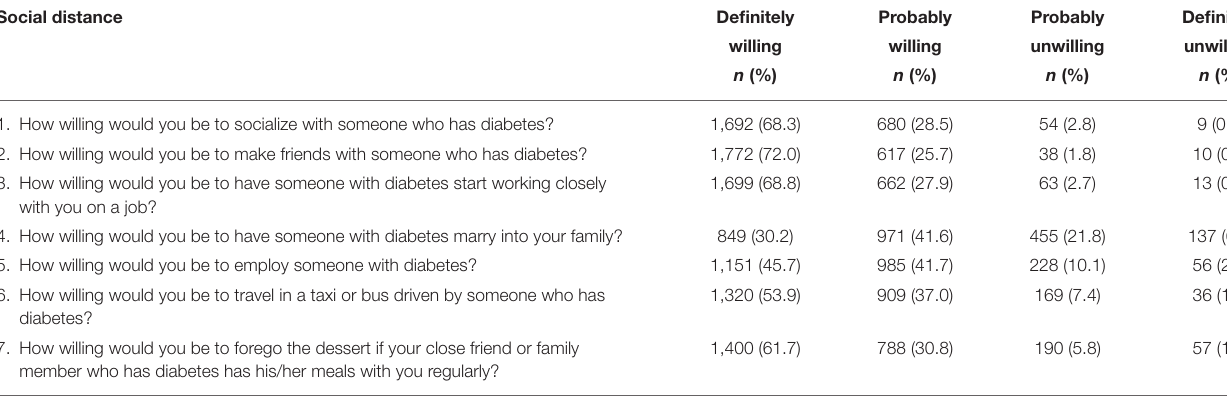
TABLE 2A | Frequency of endorsement of the items of the social distance scale. Social distance